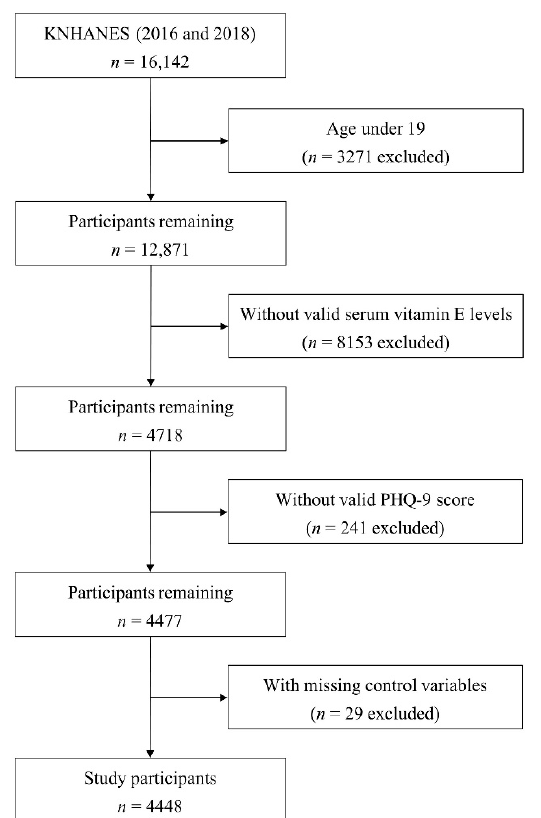
Figure 1. Flow diagram of the study participants. KNHANES, Korean National Health and Nutritional Examination Survey; PHQ-9, Patient Health Questionnaire-9.